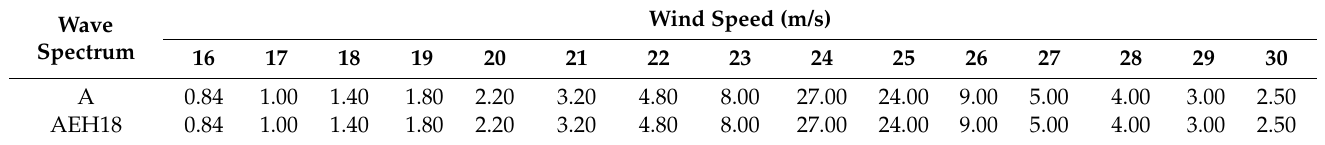
Table 4. The ζ values at different wind speeds under incidence angle of 40 ◦